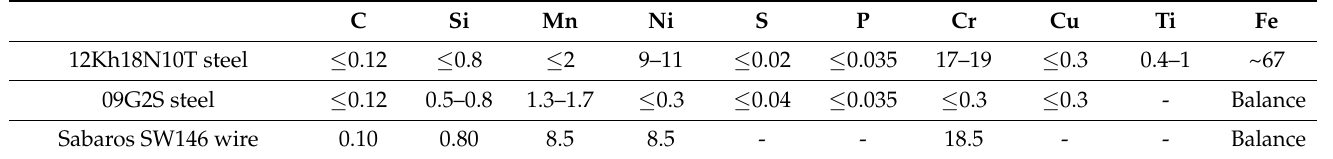
Table 1. Chemical composition of welded steels and filler wire,